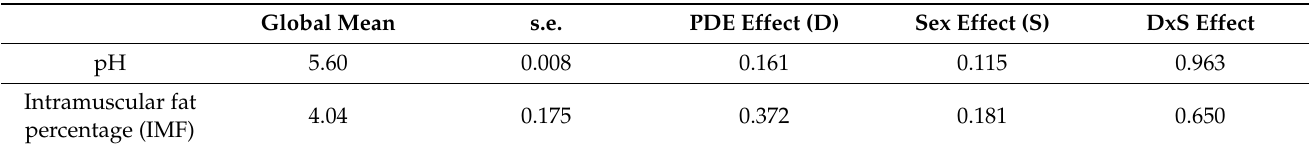
Table 1. The p values and global means for the effect of the sex and plant-derived extract addition on the pH and intramuscular fat